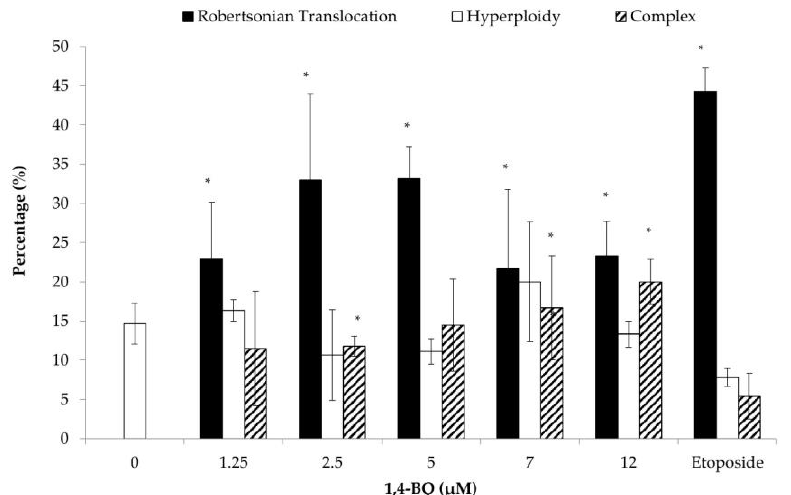
Figure 10. Effect of 1,4-BQ on different types of CA (Rb, hyperploidy, and complex) in erythroid progenitor cells harvested after 7 days of CFU assay following pre-exposure of MBMCs to 1,4-BQ for 24 h. Twenty metaphases were scored for each experimental group and the percentage of each type of CA is as presented. Data are presented as the mean ± S.E.M. ( n = 3) and analyzed by using one-way ANOVA. * p < 0.05 compared with the negative control